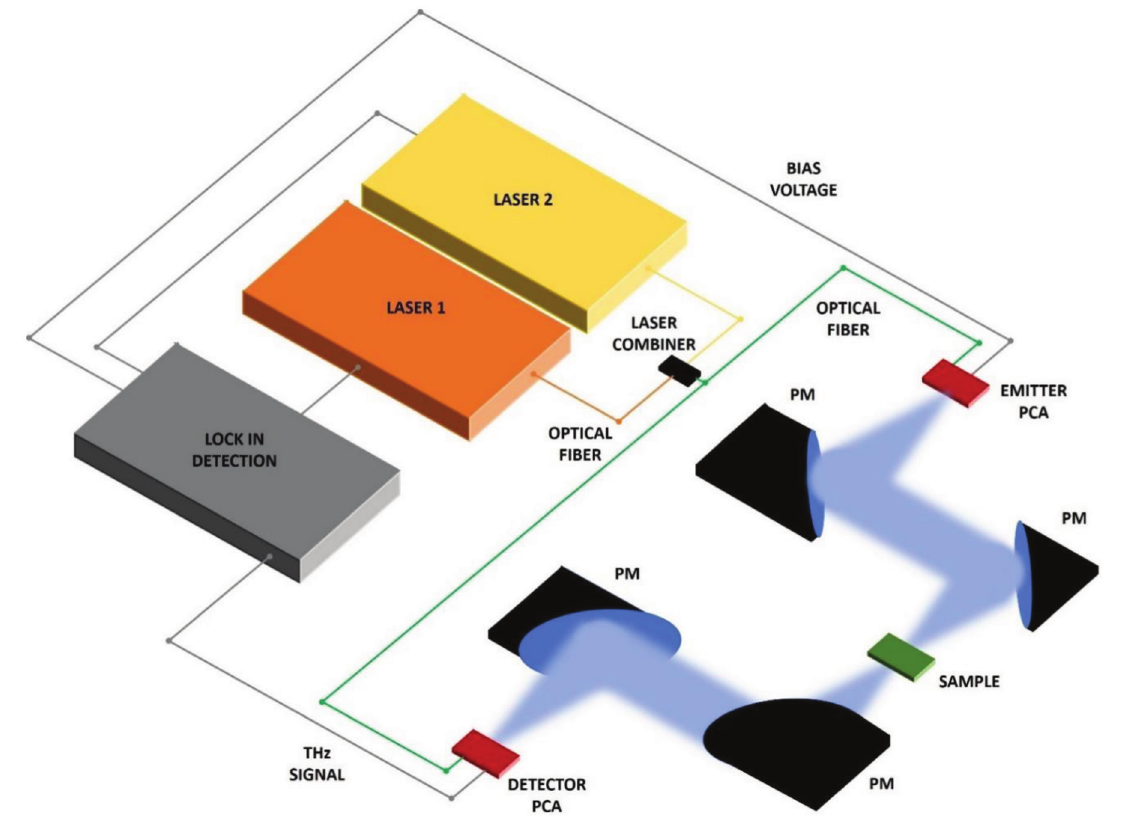
Figure 5: Schematic layout of THz-FDS setup. Two continuous wave tunable lasers at adjacent frequencies beat in a laser combiner and illuminate the THz emitter and receiver for THz generation and detection. Optical fibers are used to carry out laser signals. A 4-parabolic mirror (PM) system collimates and focuses THz radiation along the path. If only 2-PM system is used the sample is placed in the collimated region of the THz beam. The acquisition chain is based on lock in detection (original